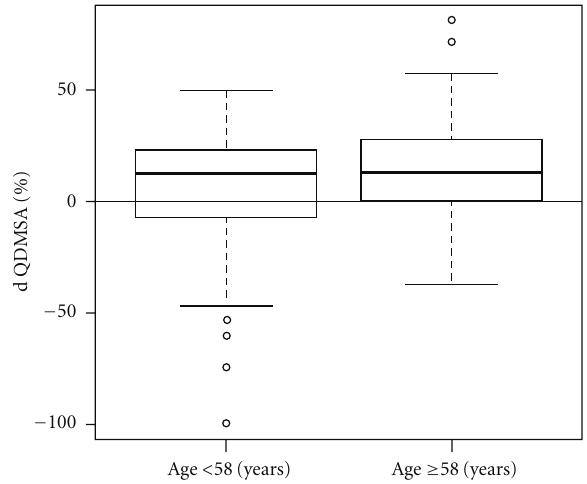
Figure 3: Mean change of postoperative renal function of the operated kidney as measured by QDMSA stratified according to duration of warm ischemia ( P = 0 .